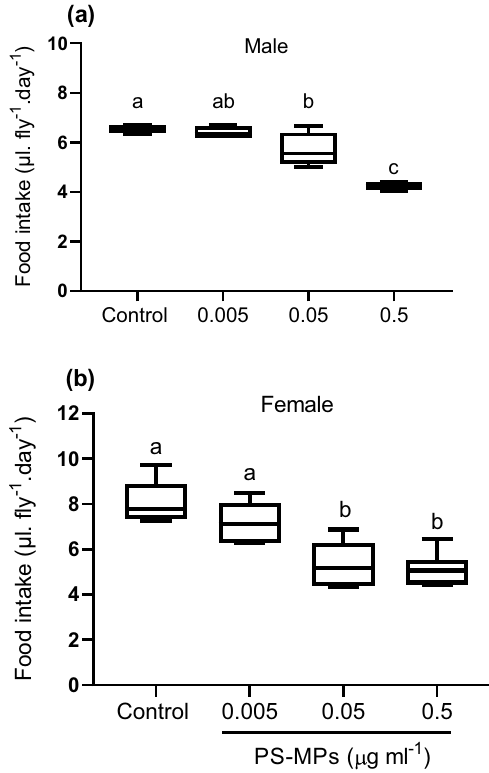
Figure 2. Food intake (μl. day −1 . fly −1 ) of adult ( a ) male and ( b ) female flies (n = 9) fed sucrose solution (5% w/v) mixed with different PS-MPs (0.5, 0.05, 0.005 µg/ml) compared to flies fed non-treated (control) sucrose solution. Different lowercase letters indicate statistical differences between treatments (One way ANOVA, p <